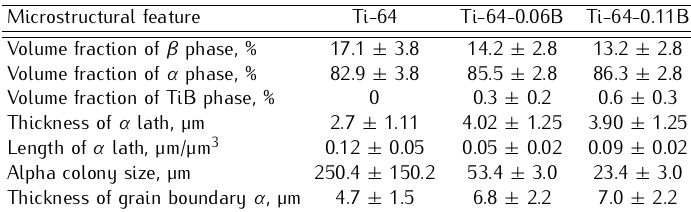
Table 2. Summary of quantitative metallography of microstructural features.